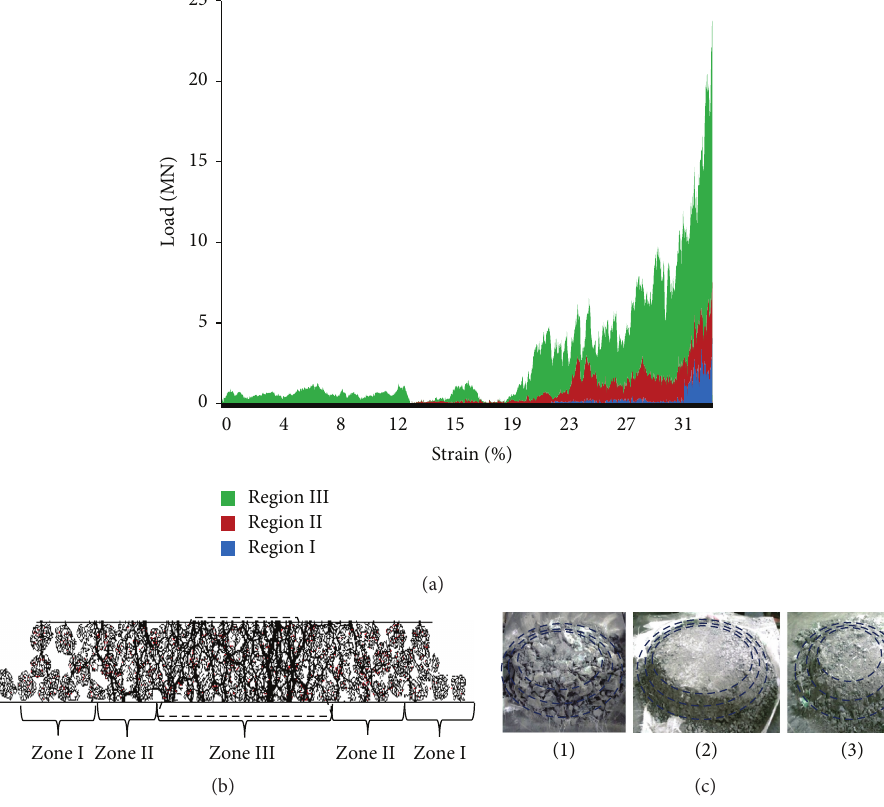
Figure 11: The spatial characteristic of spoils under unconfined compression and the comparison of the consolidated zones. (1) Large particle size; (2) small particle size; (3) Talbot’